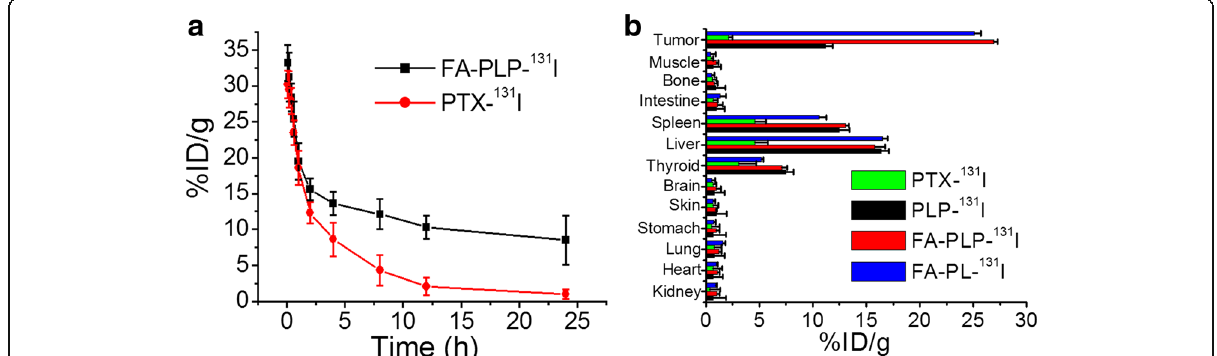
Fig. 6 a The blood circulation curve of FA-PLP- 131 I after intravenous injection. b Biodistribution of PTX- 131 I, FA-PL- 131 I, FA-PLP- 131 I, and PLP- 131 I in B16F10 tumor-bearing mice